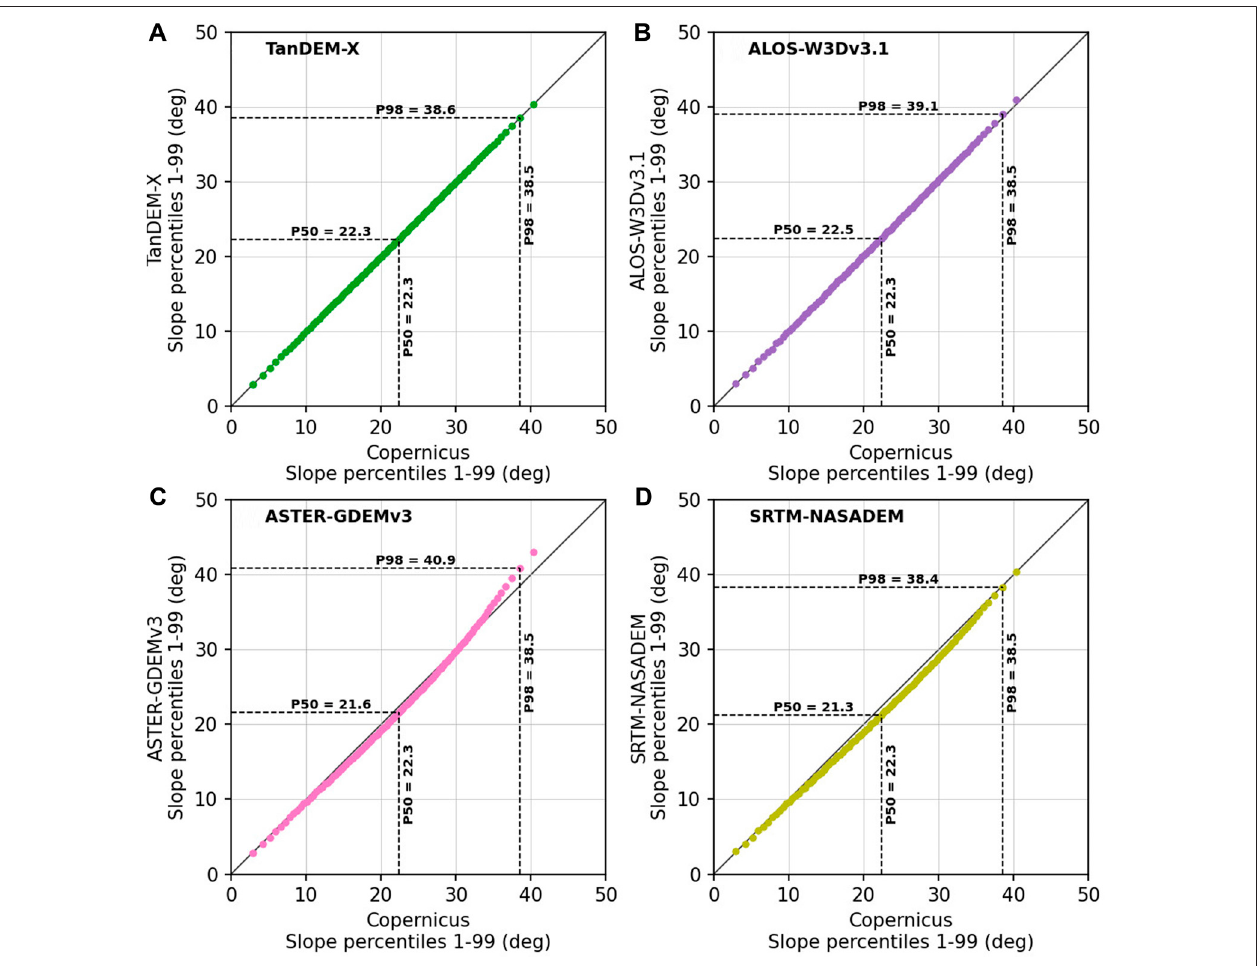
FIGURE 11 | Catchment slope percentile-percentile plots on cubic spline resampled 30-m DEMs. All three slope distributions for the three test catchments ( Figure1 )arecombined,withseparateplotsforeachcatchmentshownin SupplementaryFiguresS3 – S5 .PercentilesarecomparedagainstCopernicus( x -axisonall plots) for (A) TanDEM-X, (B) ALOS-W3Dv3.1, (C) ASTER-GDEMv3, and (D) SRTM-NASADEM. The maximum relative percentage difference in slope compared to Copernicusapproaches0.3,1.5,6.2,and4.5%fortheTanDEM-X,ALOS-W3Dv3.1,ASTER-GDEMv3,andSRTM-NASADEM,respectively.Slopewascalculated with the Zevenbergen and Thorne (1987) algorithm, and Supplementary Figure S6 presents the results using the alternative Horn (1981) algorithm.